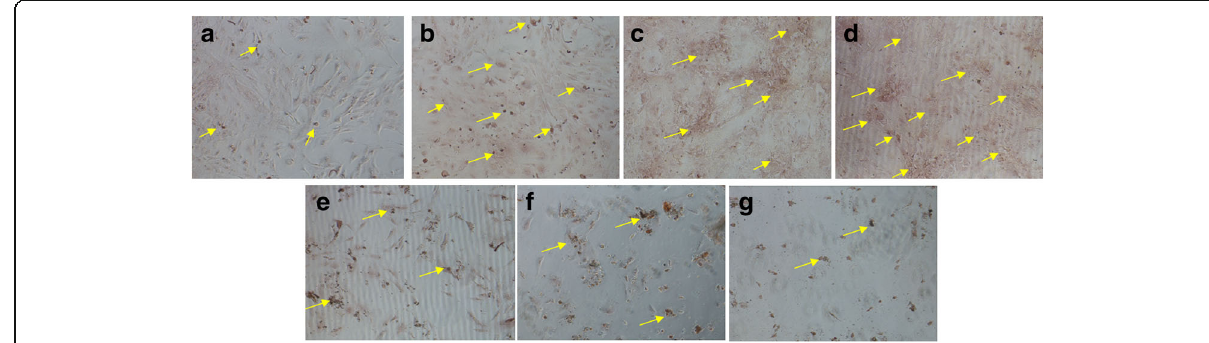
Fig. 2 Levels of mineralized nodule formation assay. Osteoblasts were incubated with different concentrations of KFX and positive control for 7 days and then stained with Alizarin-S red as a measure of osteoblast mineralization. a Blank control (untreated), b KFX (0.1 mg/mL), c KFX